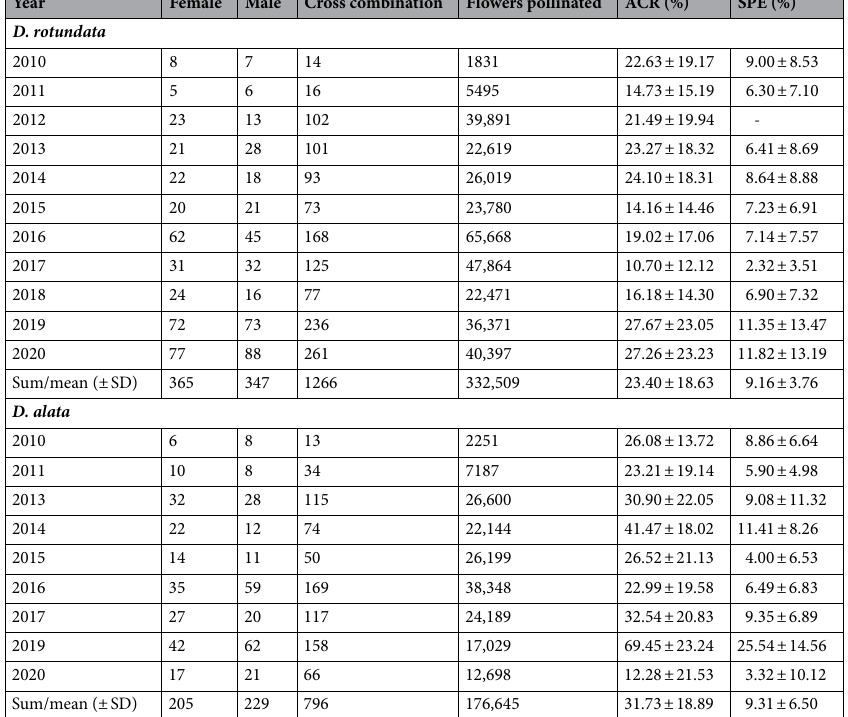
Table 5. D. rotundata and D. alata average crossability rate (ACR) and seed production efficiency (SPE) for 2010–2020 at IITA. ACR = average crossability rate, SPE = seed production efficiency. ACR and SPE are presented by means ± standard deviation